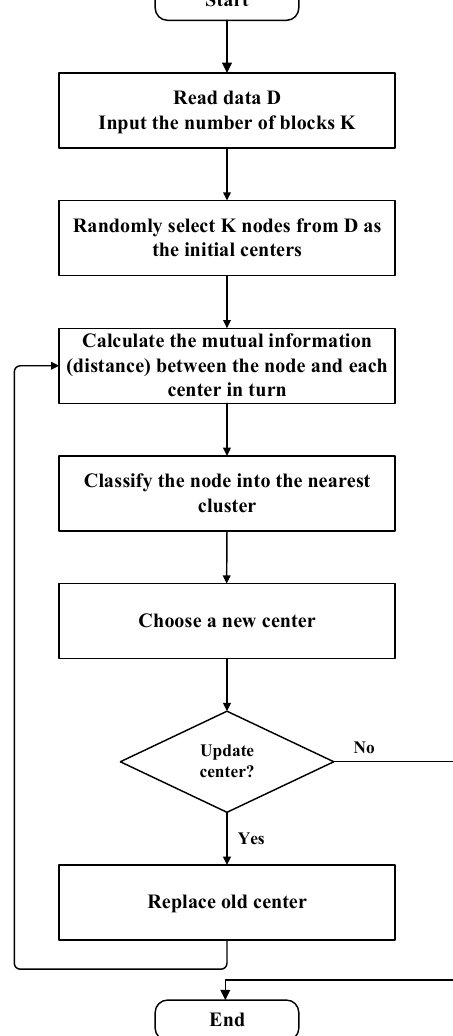
Figure 1. Flowchart of mutual information based K-means algorithm (MKM algorithm).